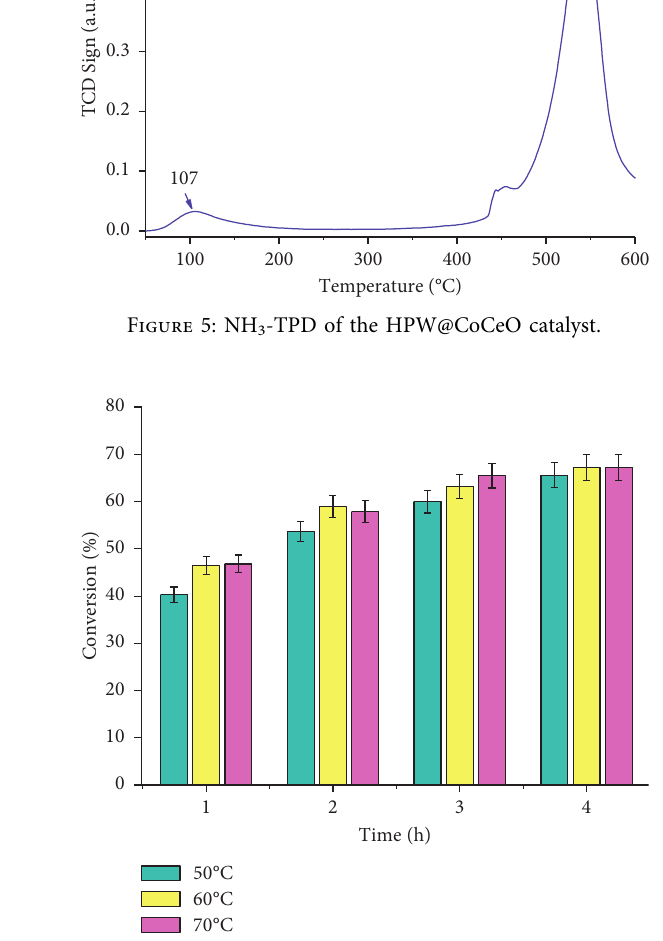
Figure 6: The effect of reaction temperature on the oleic acid conversion over the HPW@CoCeO